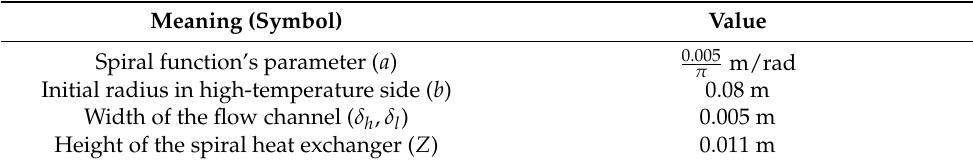
Table A1. Parameters of a spiral heat